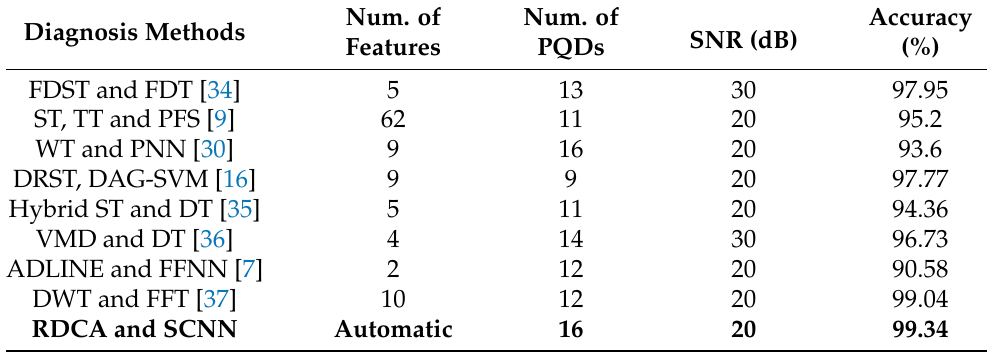
Table 3. PQD classification performance